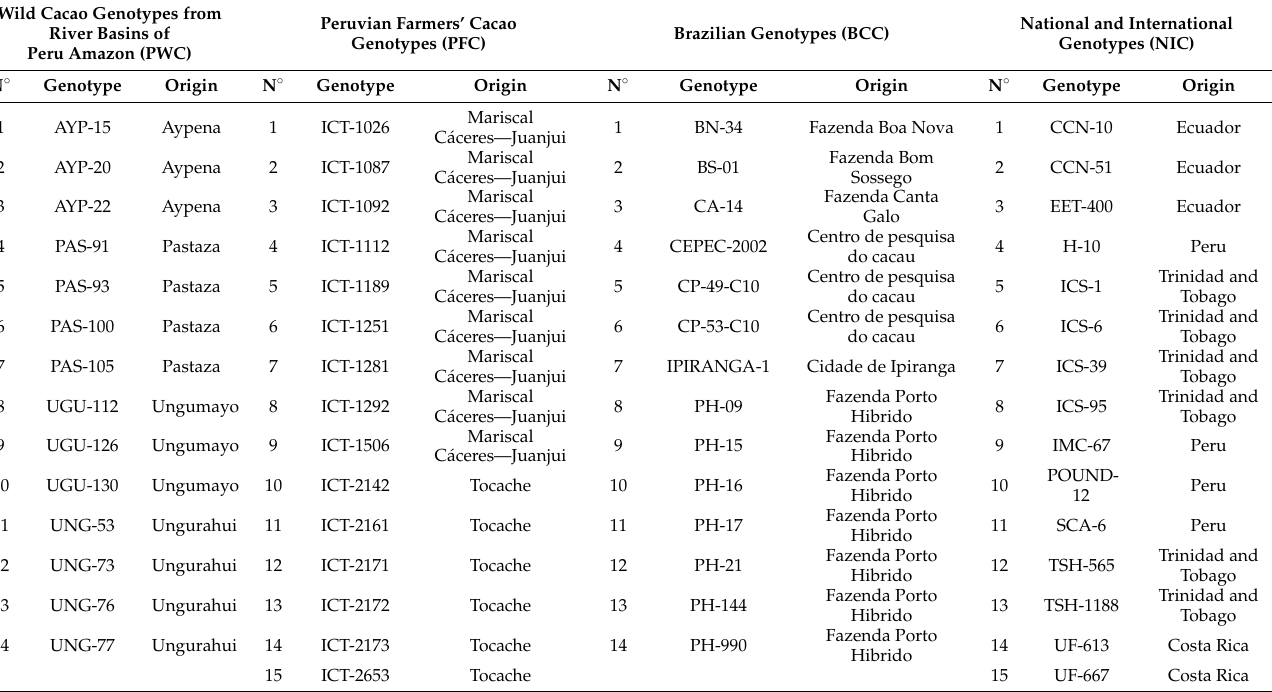
Table 1. List of 58 cacao genotypes used for this experiment from 4 different origins maintained at the ICT germplasm bank. Wild Cacao Genotypes from Peruvian Farmers’ Cacao River Basins of Genotypes Peru Amazon (PWC)